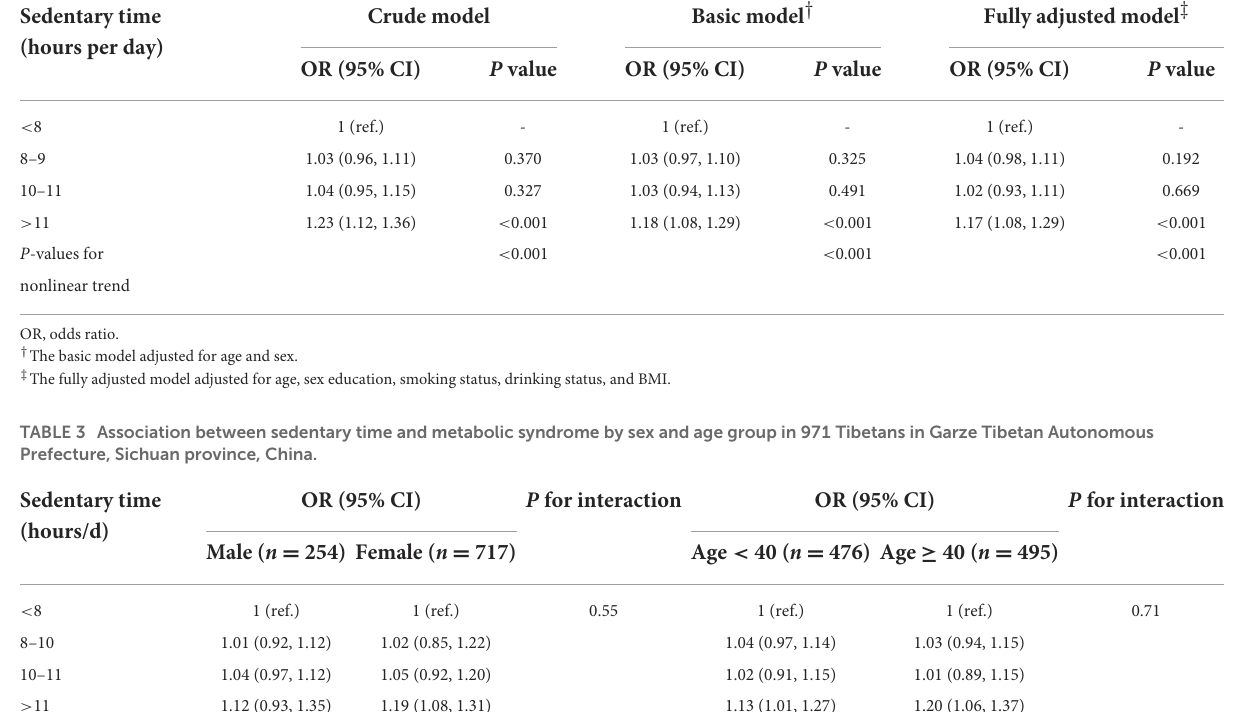
TABLE 2 Association between sedentary time and metabolic syndrome in 971 Tibetans in Garze Tibetan Autonomous Prefecture, Sichuan province, China.